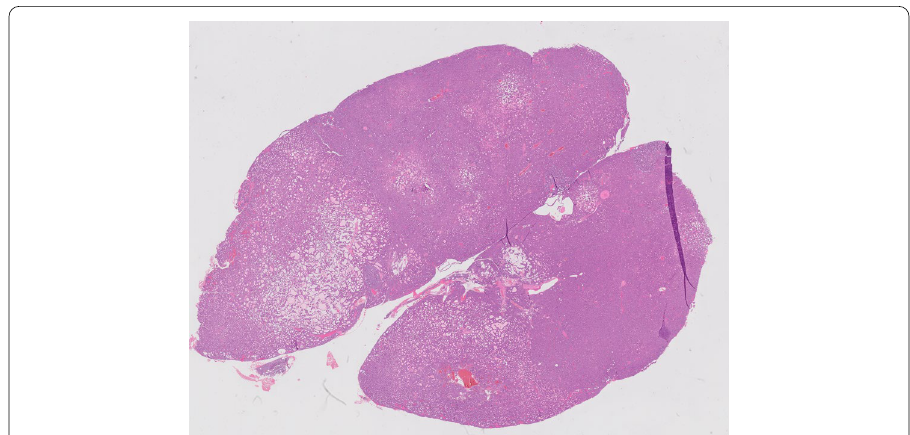
Fig. 2 Hematoxylin and eosine staining (magnification 12.5) showing parathyroid tissue (partly solid, partly follicular growth pattern) consistent with a PTA (diameter 2.4